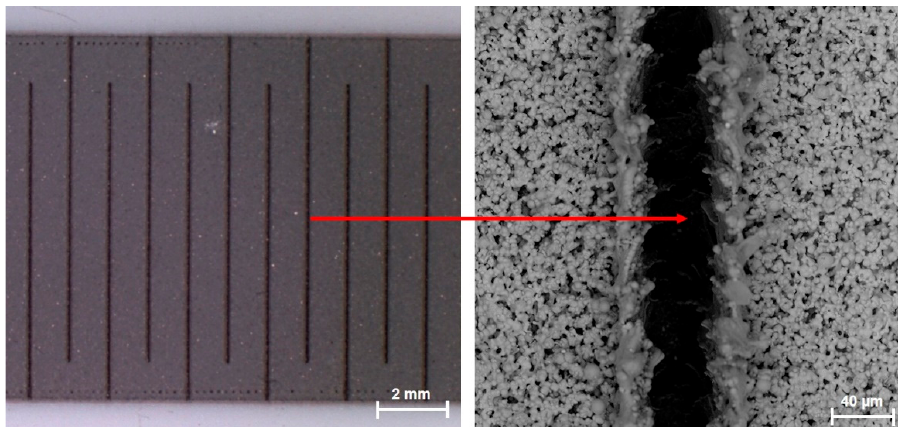
Figure 8. Copper-nickel resistor after laser trimming and SEM image of detail morphology of laser cut.